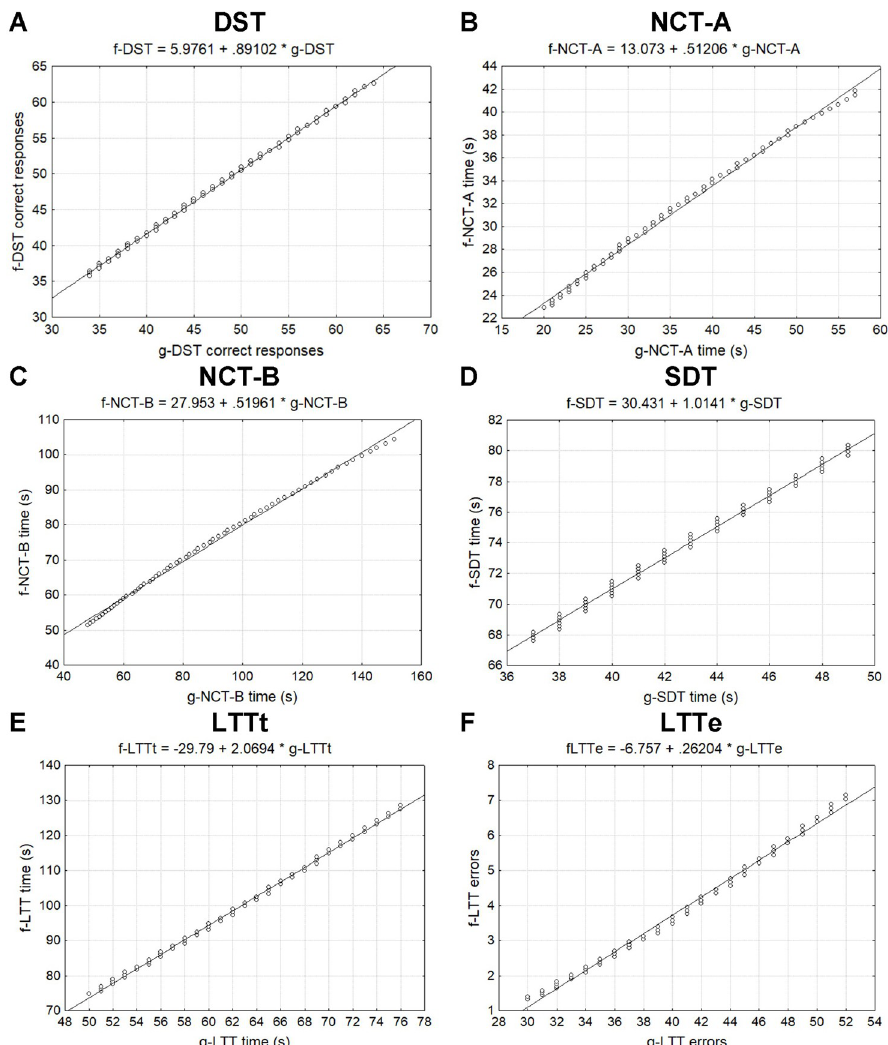
Fig 3. Comparison between French and seminal German norms. Correlation scatterplots of (A) correct responses in Digit Symbol Test (DST), time in seconds in (B) Number Connection Test part A (NCT-A), (C) NCT-B, (D) Serial Dotting Test (SDT), (E) Line Tracing Test (LTTt), and (F) errors in LLT (LTTe) of French (f) participants on y axis as a function of German (g) participants on x axis. Subtitles are regression